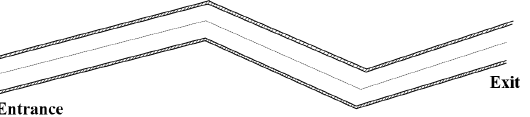
Figure 1. A typical narrow corridor with definite boundaries. The corridor is comprised of three segments. Hence, this corridor can be represented by the parameter groups A l i ∈ { 1,2,3 } .